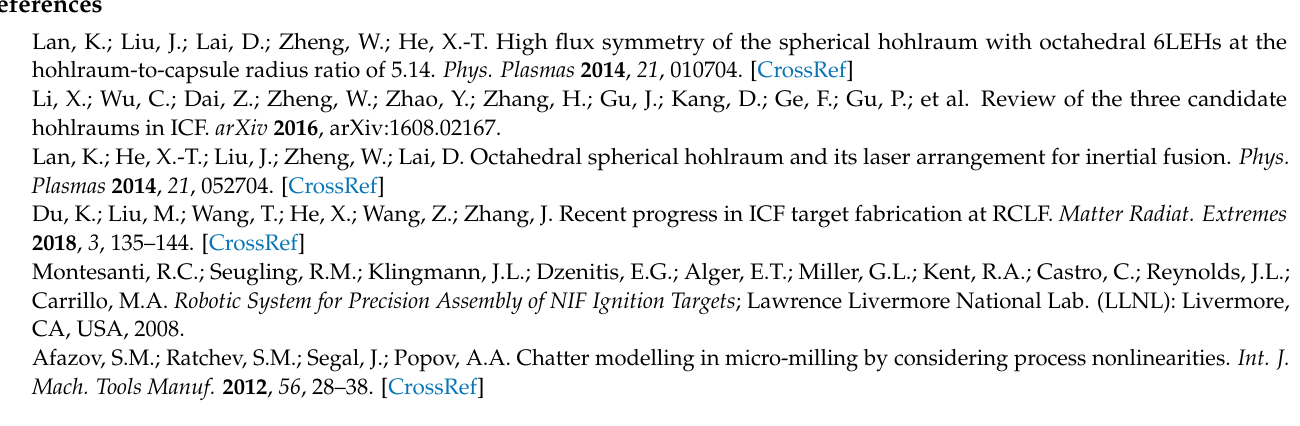
Figure 10. FE simulation results of the effect of spindle speed on ( a ) the maximum deformation of the milling tool and ( b ) the microscopic roughness Rz of the machined surface.